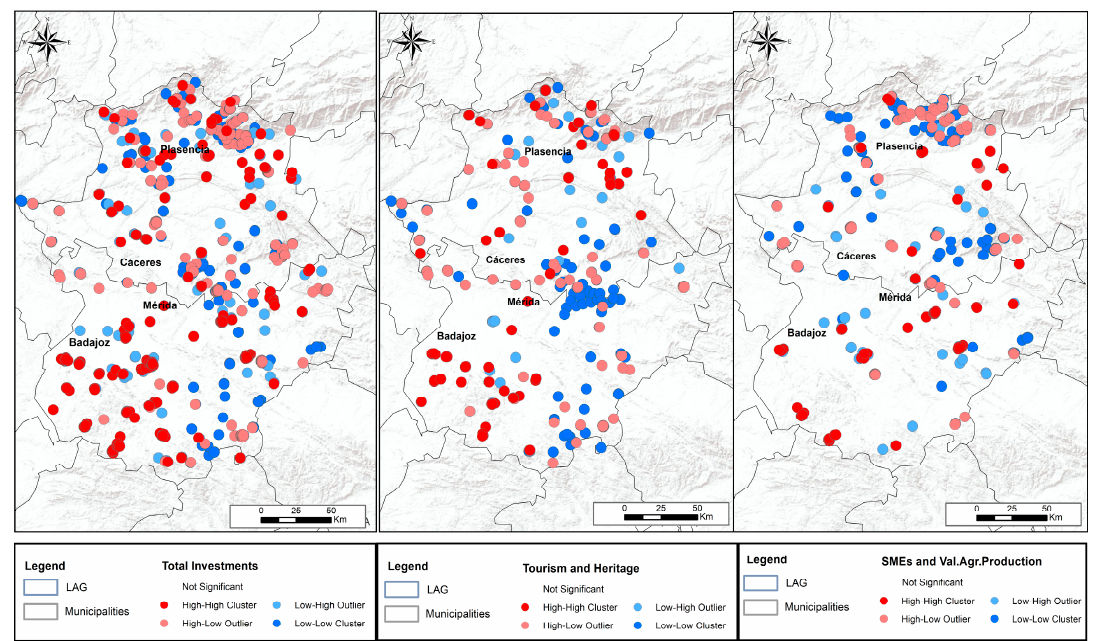
Figure 5. Local Moran’s I of LEADER Approach (2000–2013).